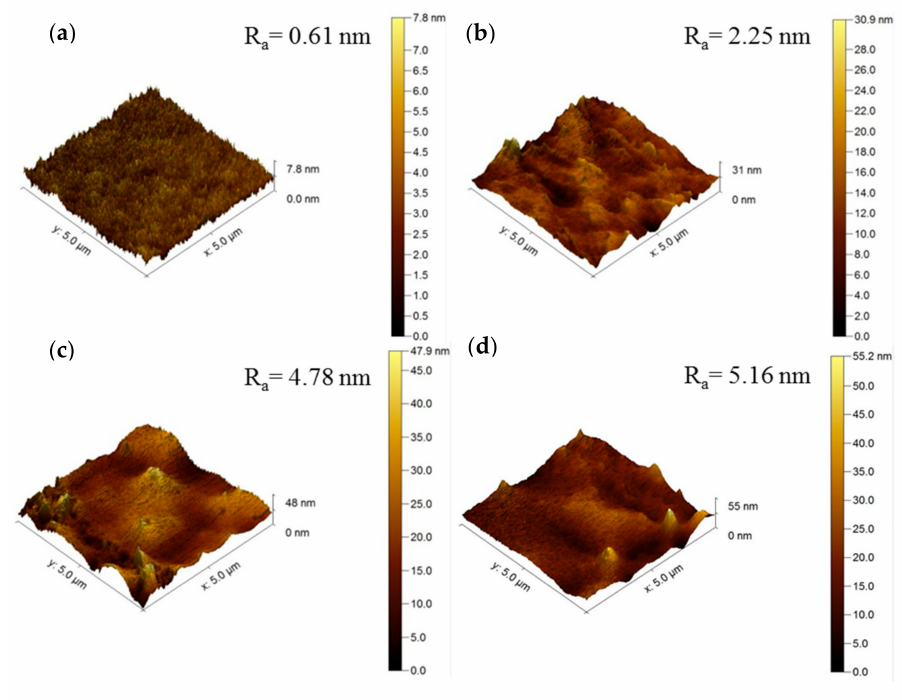
Figure 6. 3D AFM images of membranes with di ff erent nanomaterial loadings: ( a ) 0.0 wt%, ( b ) 0.4 wt%, ( c ) 0.8 wt%, and ( d ) 1.0 wt%